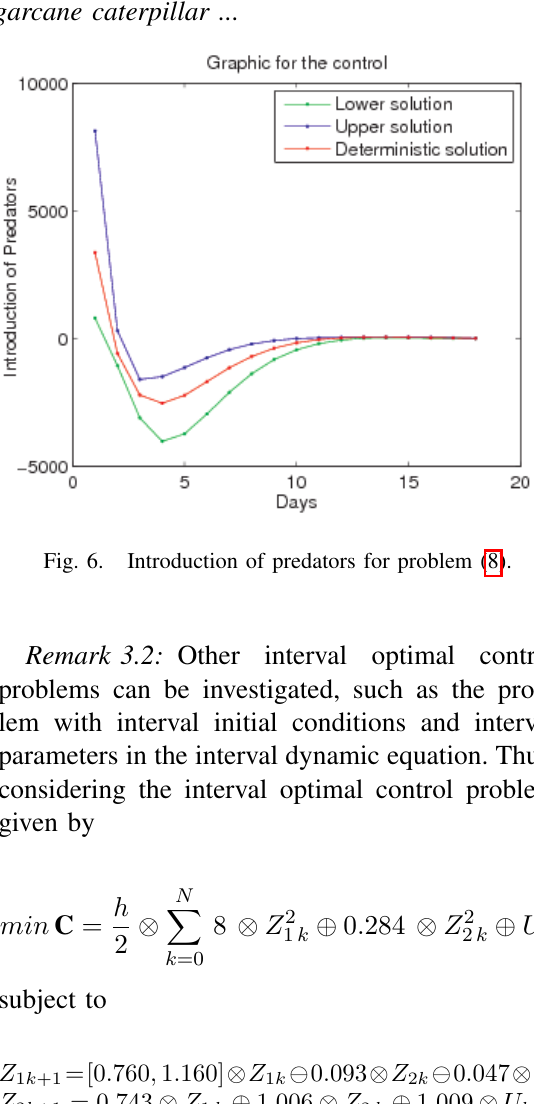
Fig. 5. Predators for problem (8).